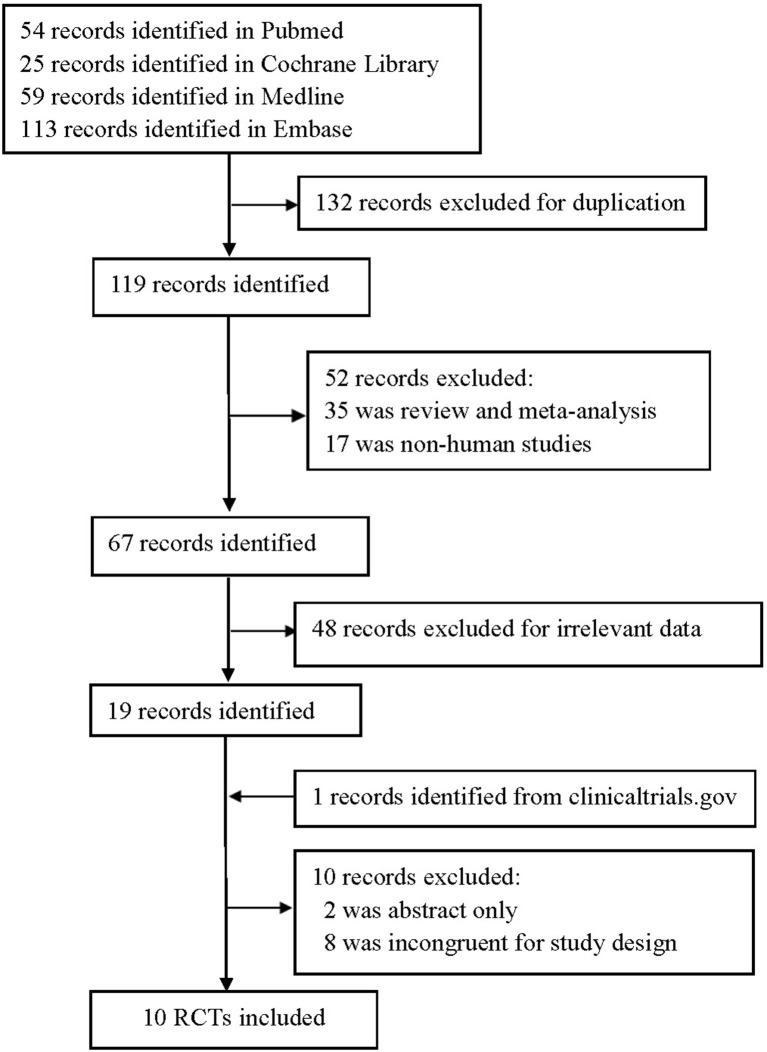
Flow chart of selected study.